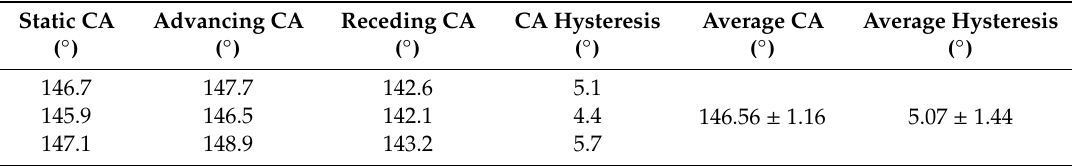
Table 5. Static water contact angle (CA) measurements and contact angle hysteresis on travertine samples covered with octyl-modified silica nanostructured